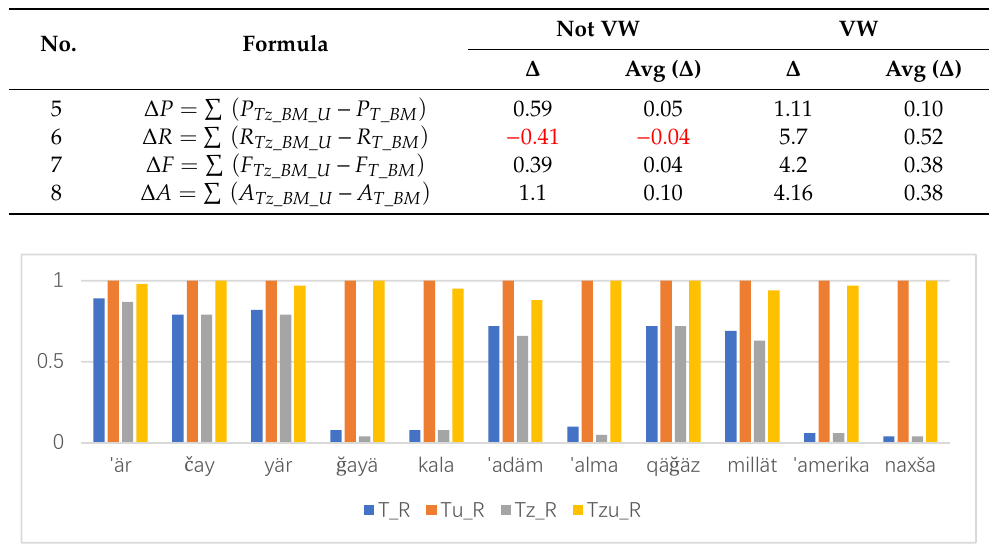
Table 8. Comparison of Tz retrieval by BM-U algorithm and T retrieval by BM algorithm.